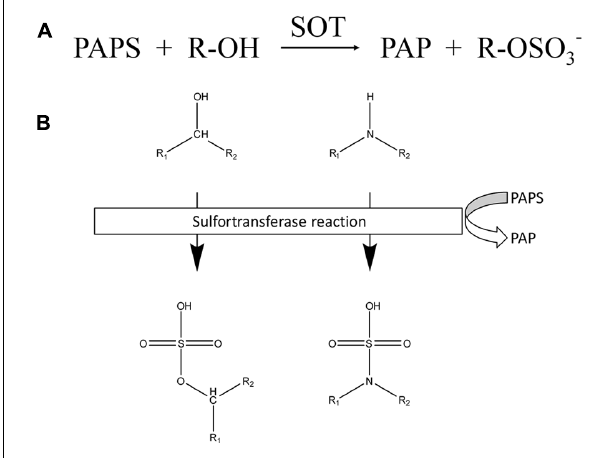
FIGURE 1 | Reactions catalyzed by SOTs. (A) Chemical equation of reactions catalyzed by SOTs. (B) Schematic overview of SOT targets. Chemical structure of targeted hydroxyl and amide groups and their sulfated products, sulfate ester and the sulfamate